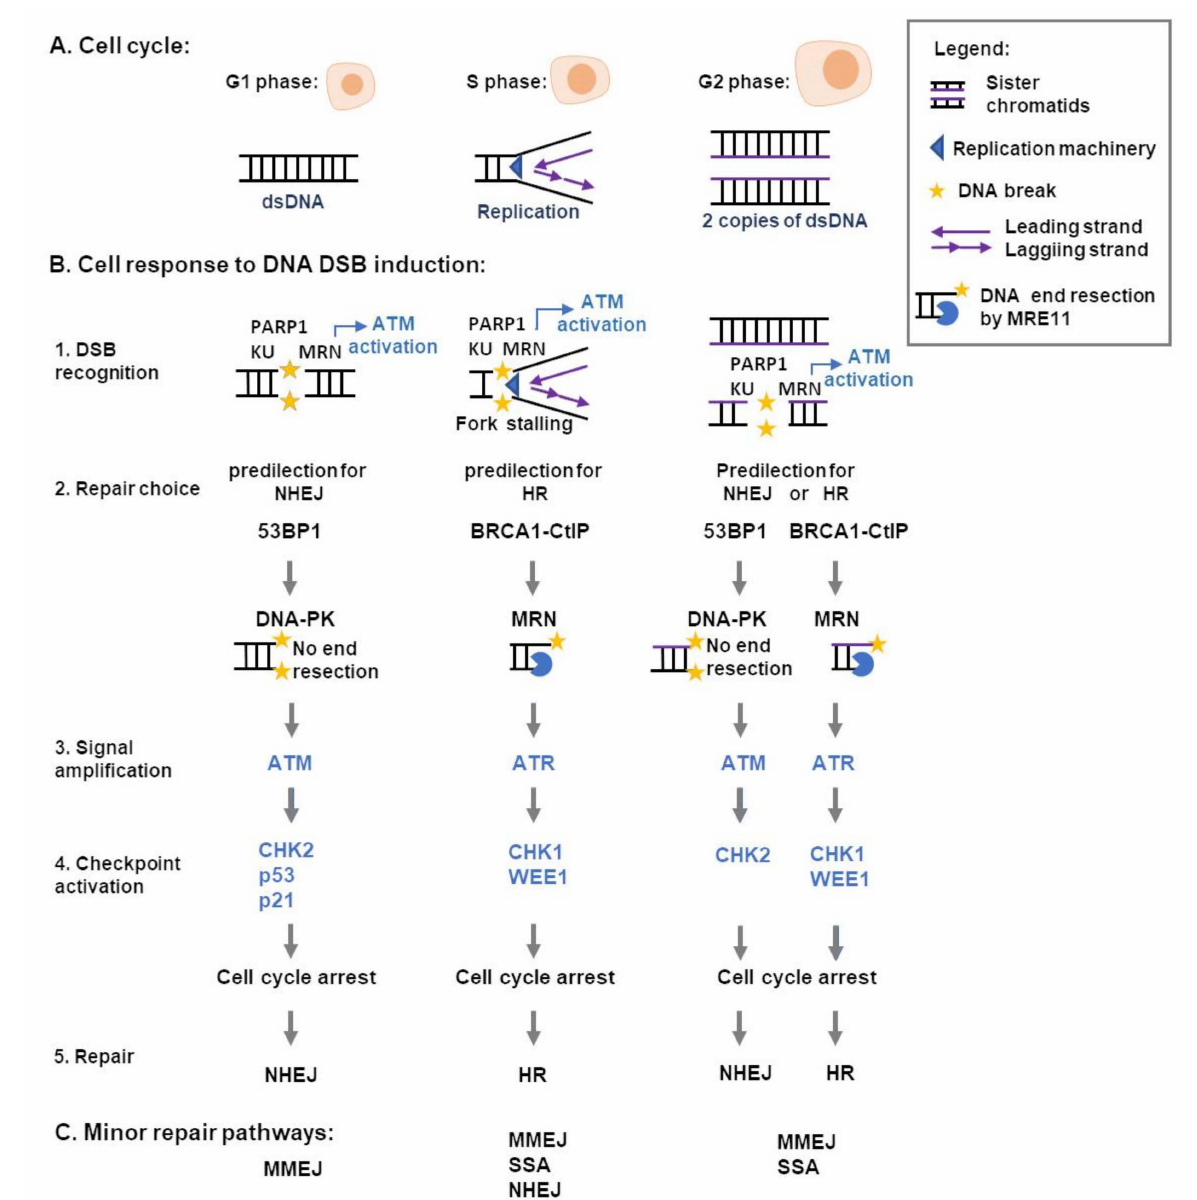
Figure 1. Cell cycle-dependent response to DSB formation. Depending on the stage of cell cycle ( A ), the induction of DSB ( B ) will lead to distinct cellular ATM or ATR signaling responses and DNA repair pathways. While DNA-PK drives NHEJ repair without resection of DNA ends, the MRN-CtIP removes DNA-PK and HR can function and use sister chromatids as a template for DNA repair synthesis. ( C ) Upon some context, including HR defect, the MMEJ and SSA repair pathways can act on the resected single-stranded DNA. MMEJ can act as a backup for NHEJ in G1